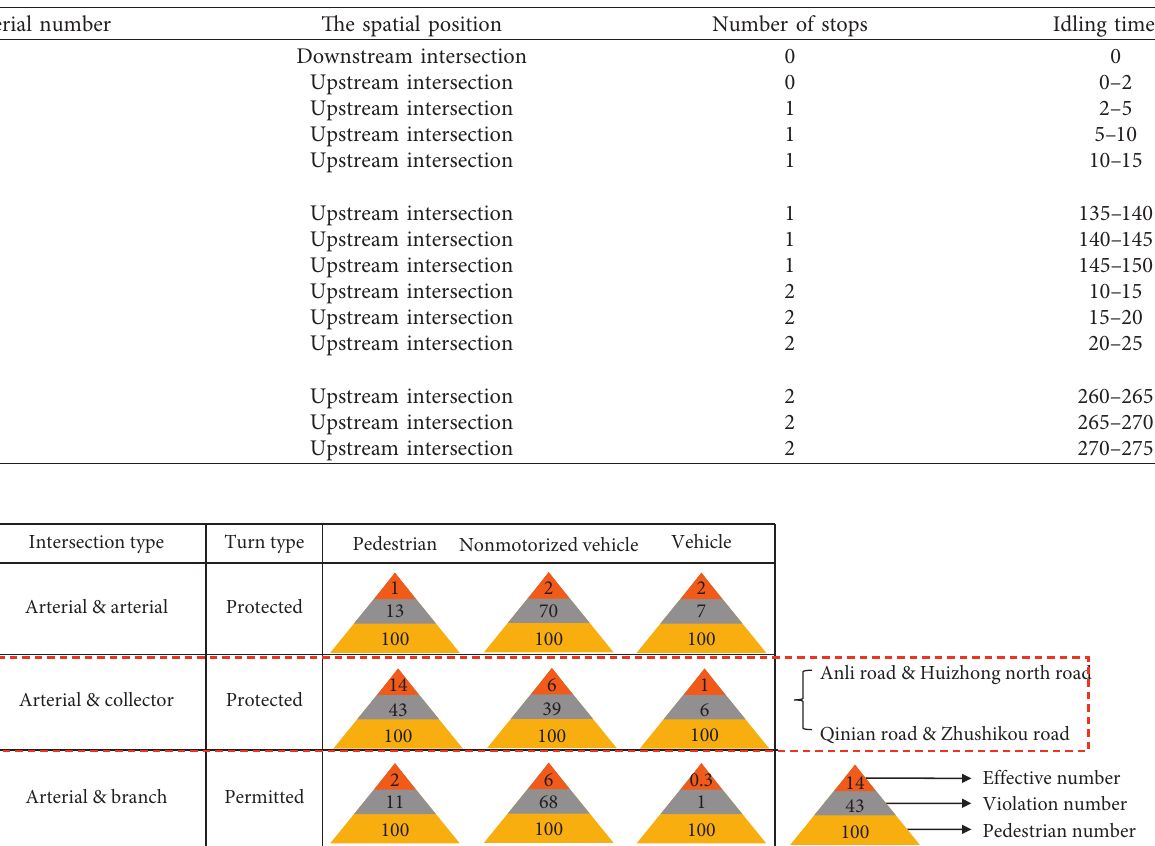
Figure 2: Overview of the Table 1: Information of the eighty-five VSP distributions [7].